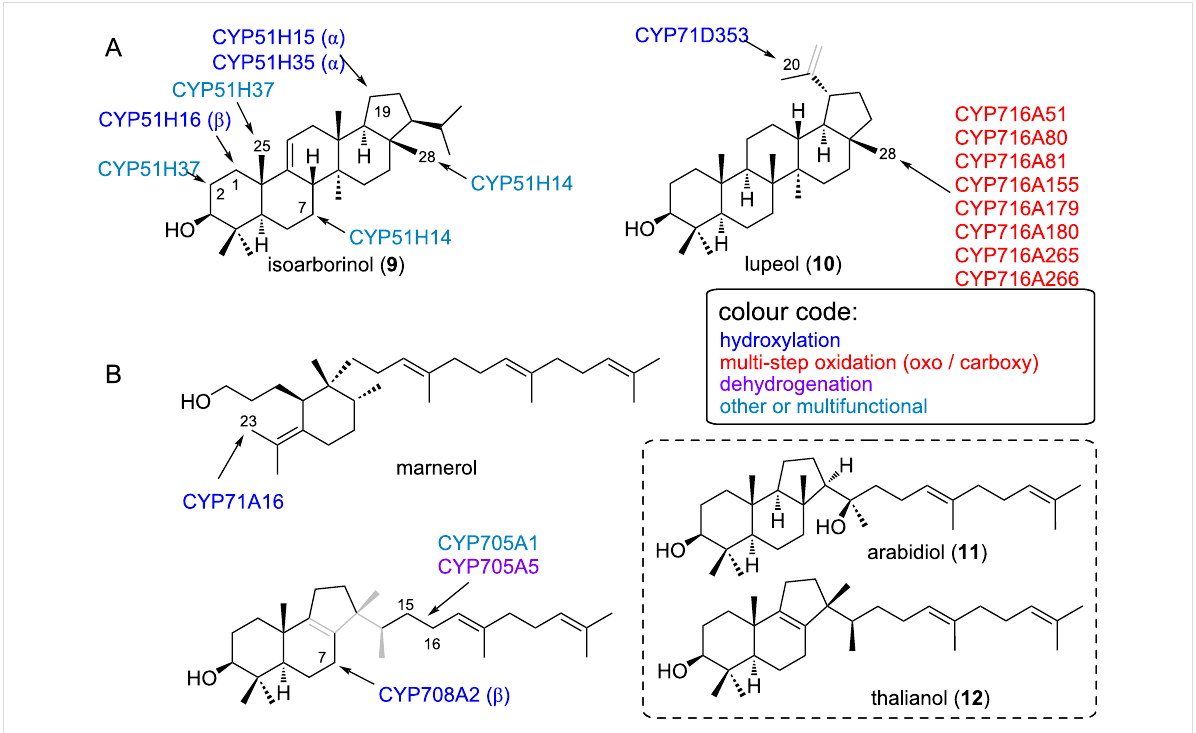
Figure 5: CYPs modifying pentacyclic 6-6-6-6-5 triterpenes (A) and unusual triterpenes (B). Substructures in grey indicate regions where major struc- tural differences occur between different substrates of the same class. Representative substrate skeletons (not exact substrates) are shown in the dotted boxes. For exact substrate specificity see Table 1.